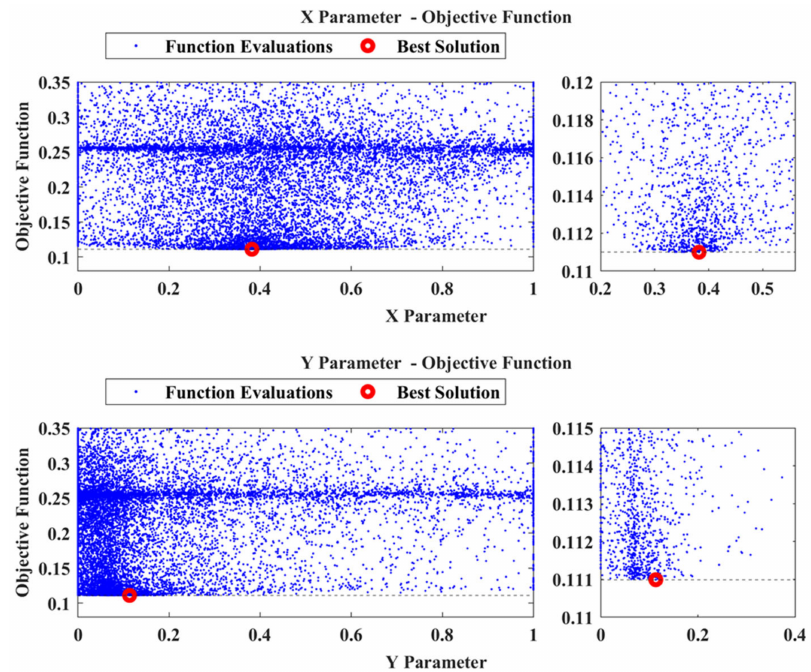
Figure 14. D1: X and Y parameters versus the Objective Function values.